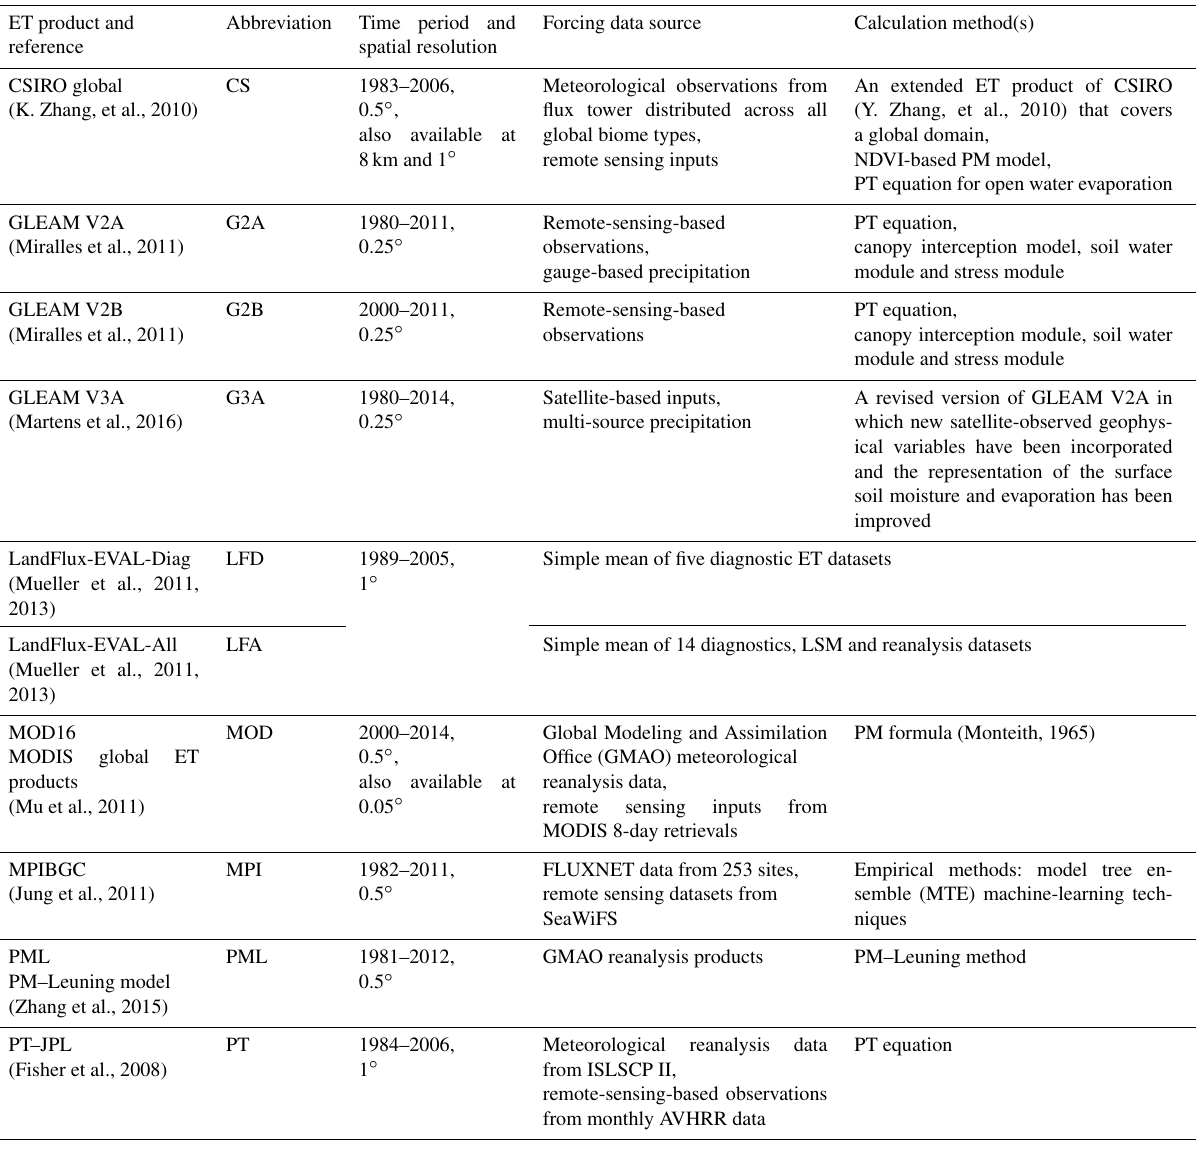
Table 1. Gridded ET products used in this paper. NDVI is the normalized difference vegetation index; ISLSCP II is the International Satellite Land-Surface Climatology Project, Initiative II; AVHRR is the Advanced Very High Resolution Radiometer; MPIBGC is the Max Planck Institute for